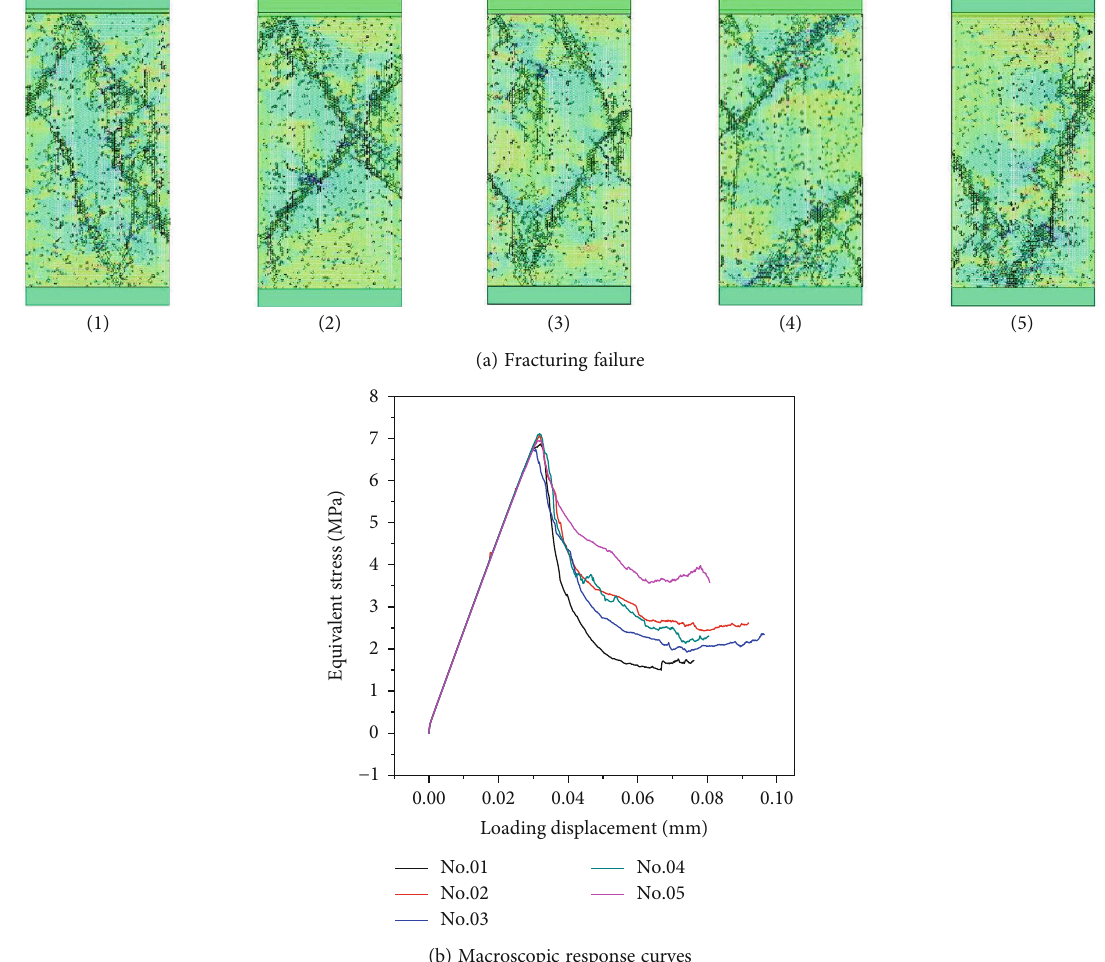
Figure 8: Simulation results of the rectangular specimen when m = 5